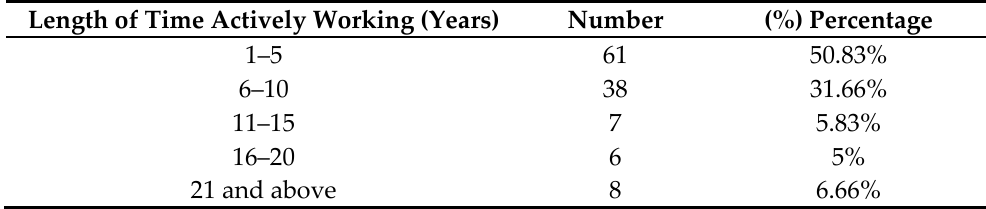
Table 6. Distribution of participants according to the length of time they had spent actively work-